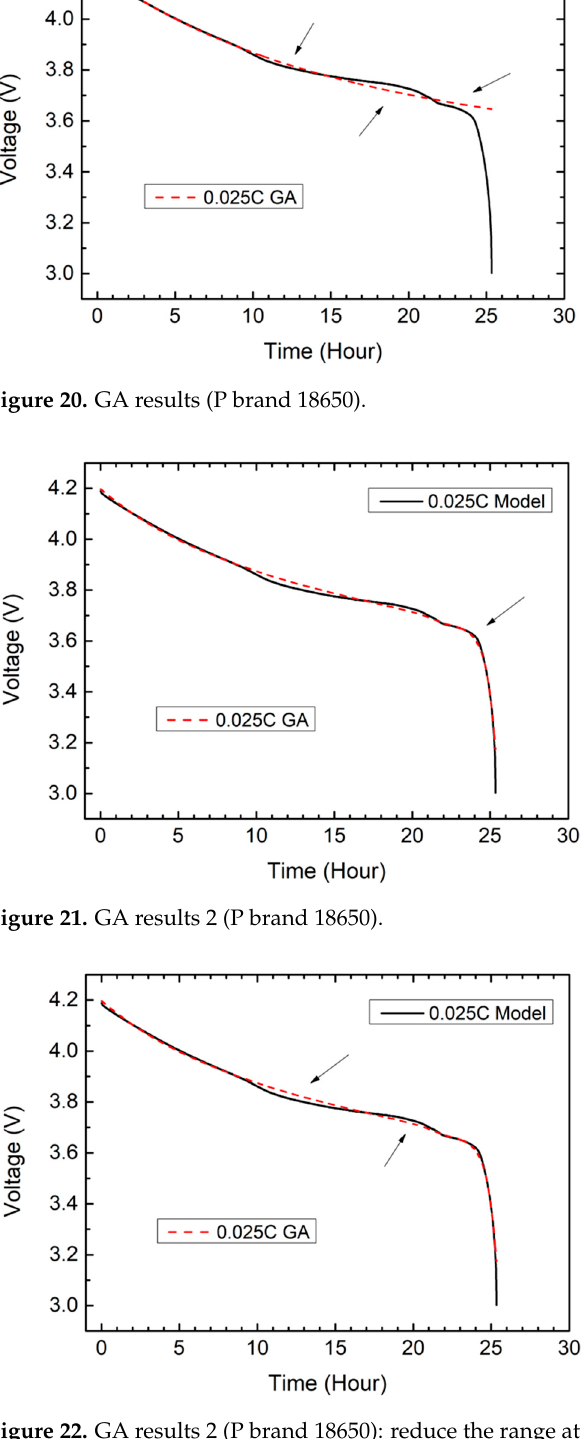
Figure 22. GA results 2 (P brand 18650): reduce the range at the arrow. Table 7 . The parameters of GA (P brand 18650).